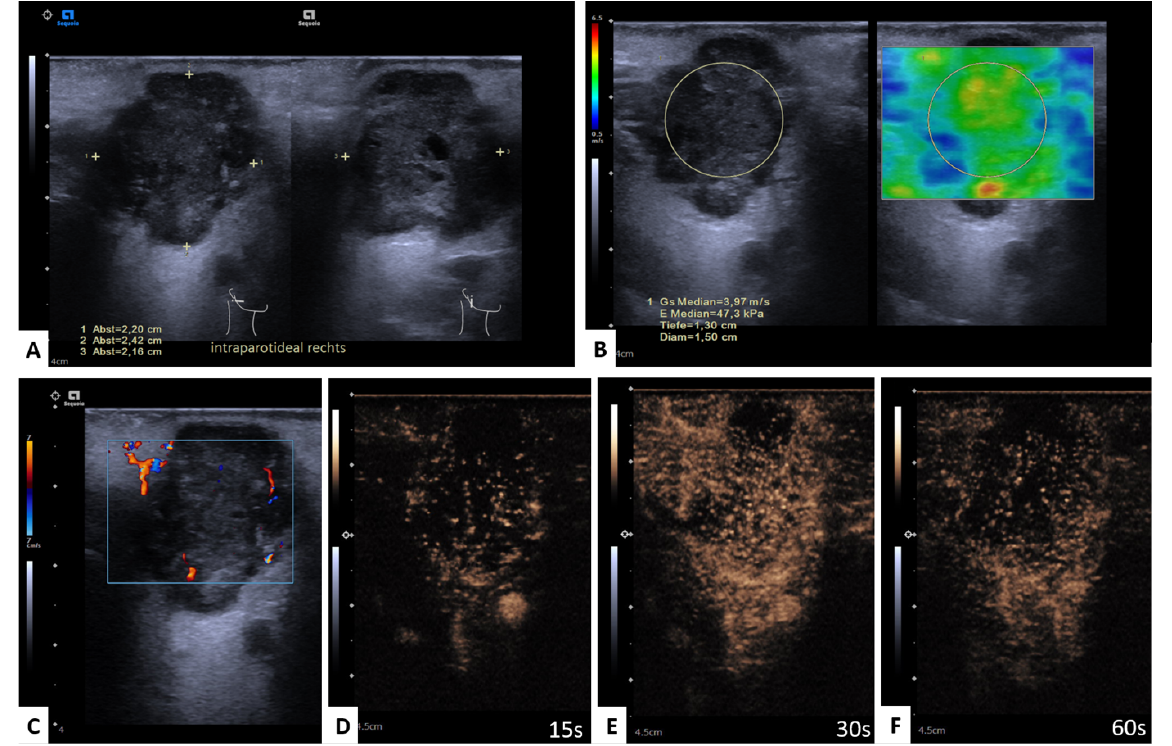
Figure 5. Malignant parotid gland lesion (squamous cell carcinoma metastasis). Representative image of mpUS workflow. ( A ) Long-axis and short-axis diameter measured in dual mode, ( B ) SWE measured by circular ROI revealed mediocre tissue stiffness with a color-coded elastography scale from blue (soft) to red (hard) and the minimum and maximum velocity given in m/s on the left side. The ROI’s stiffness is depicted on every SWE ‐ image’s left side in yellow. Please note that decimal signs on the images are depicted as commas instead of period signs due to the German ultrasound software preset. The symbol on the right side represents the position of the US ‐ probe. ( C ) Color ‐ coded Doppler US depicting irregular vascularization, ( D ) CEUS image 15 s, ( E ) 30 s, and ( F ) 60 s after contrast injection with irregular enhancement.